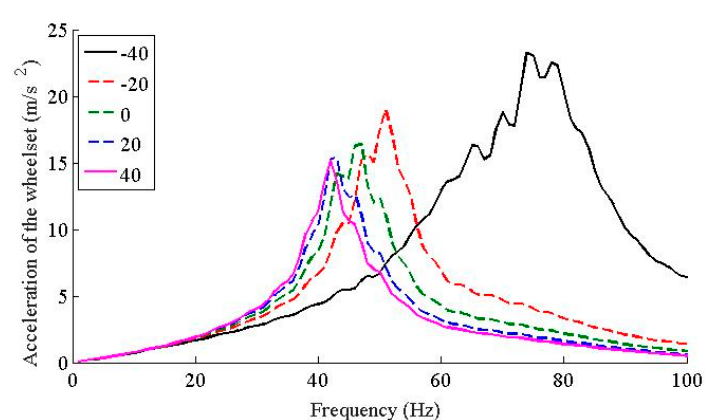
Figure 9. Vertical acceleration of vehicle under − 40, − 20, 0, 20, and 40 °C.